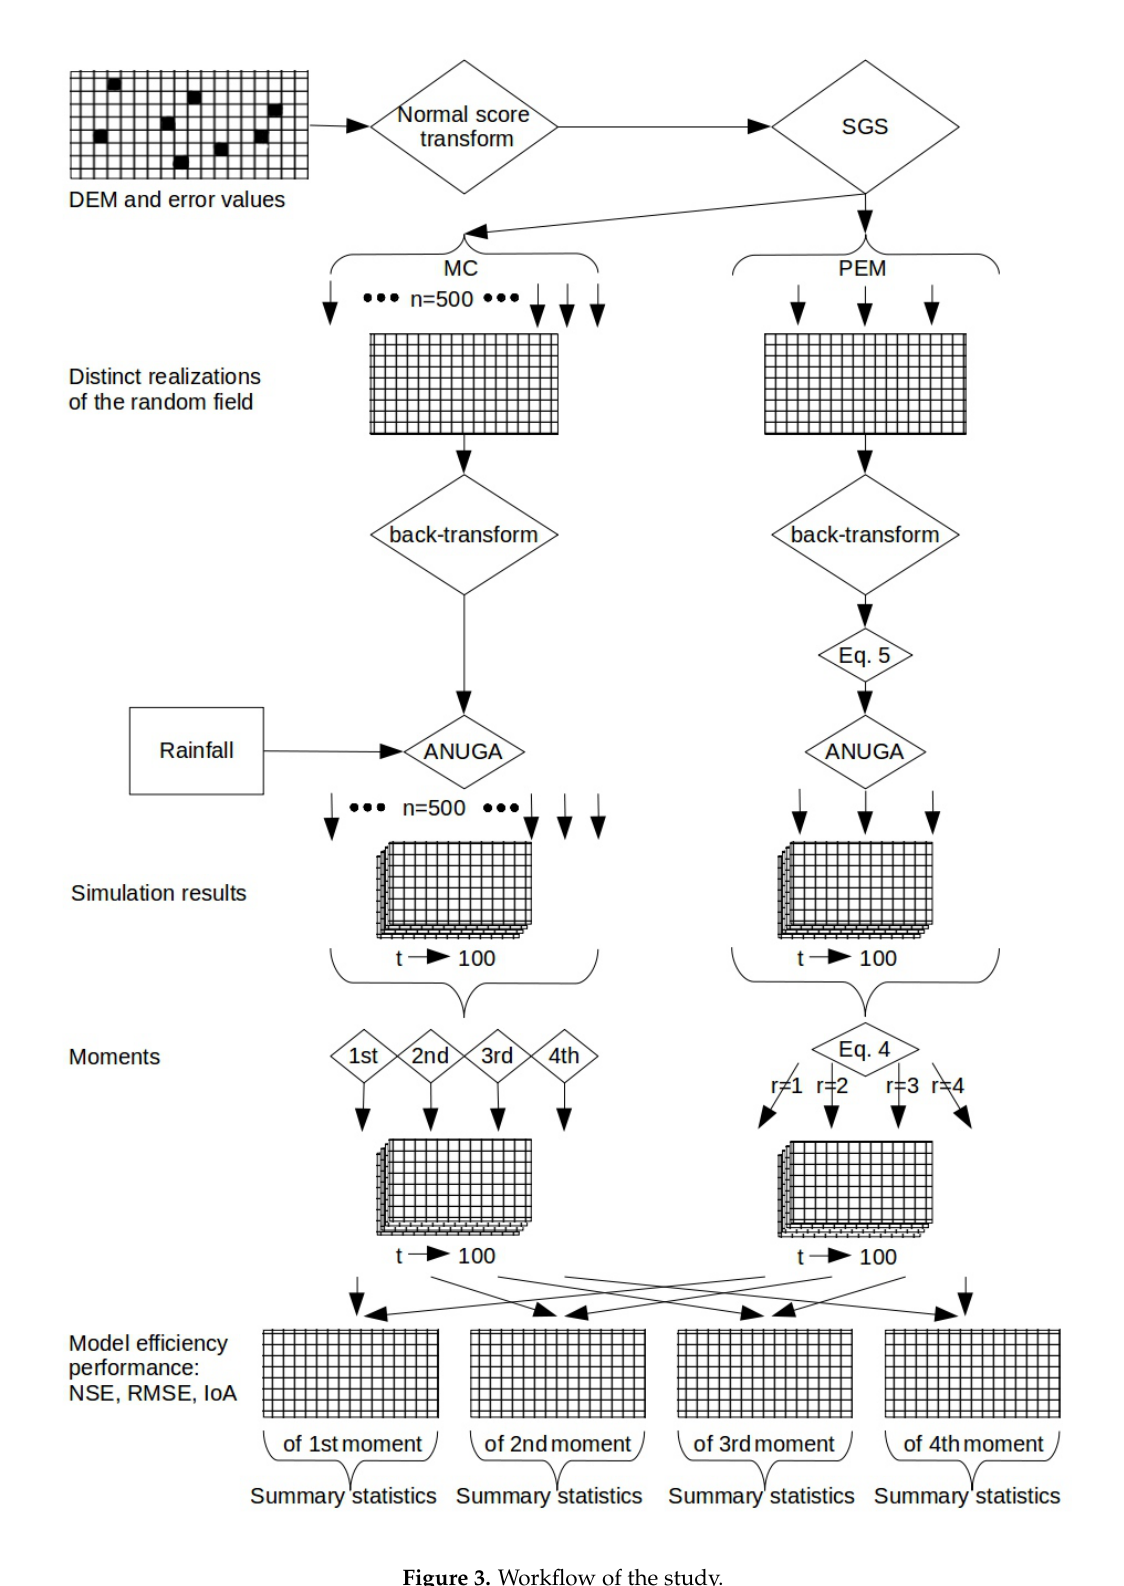
Figure 3. Workflow of the